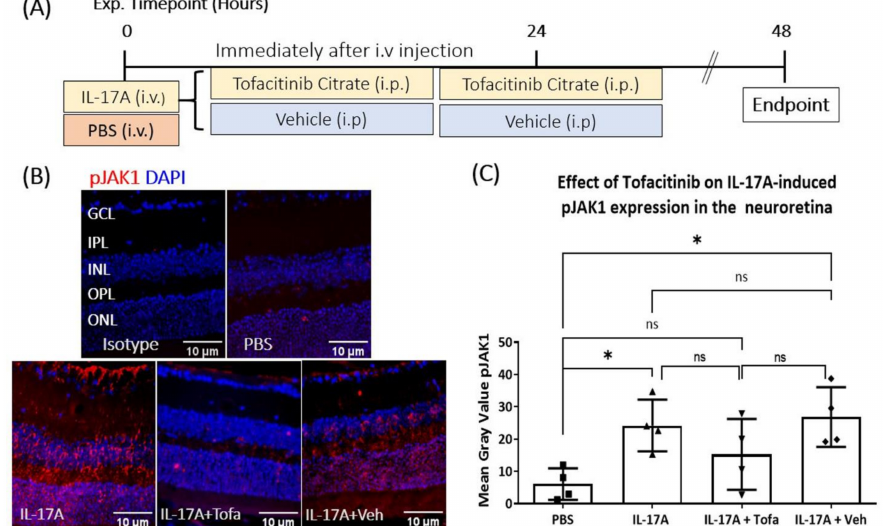
Figure 5. The effect of Tofacitinib Citrate on IL-17A-induced retinal pJAK1 expression. C57BL/6J mice received IL-17A or vehicle (PBS) i.v. injection were treated with or without Tofacitinib Citrate twice. Retinae were collected 48 h later and processed for immunostaining of pJAK1. ( A ) Schematic of experimental design. ( B ) Representative images of pJAK1 expression in retinas of mice that received PBS, IL-17A, IL-17A + Tofacitinib Citrate or IL-17A + vehicle control; n ≥ 5 animals per group. ( C ) Quantification of pJAK1 integrated density. Two or three images from the central retina were quantified per animal. Values were normalized to PBS control on the same slide. Mean ± SD. ROUT outliers test 2% was used to remove outliers. Cleaned data were compared by using One-Way ANOVA with Tukey’s multiple comparisons test, * p < 0.05; ns: no statistical